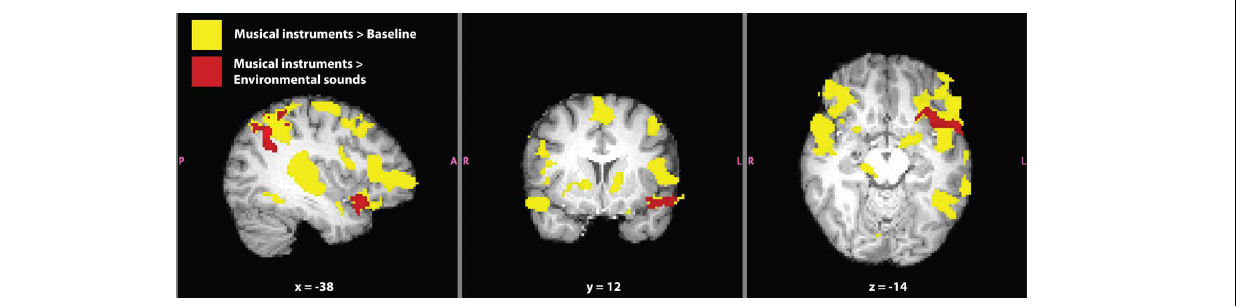
difference in synesthetic gustatory experience for SC (i.e., “more” > “less” synesthesia ) in addition to differences in types of sounds. Masks of whole-brain Z -statistic values are shown in MNI space, with SC’s normalized brain as the background